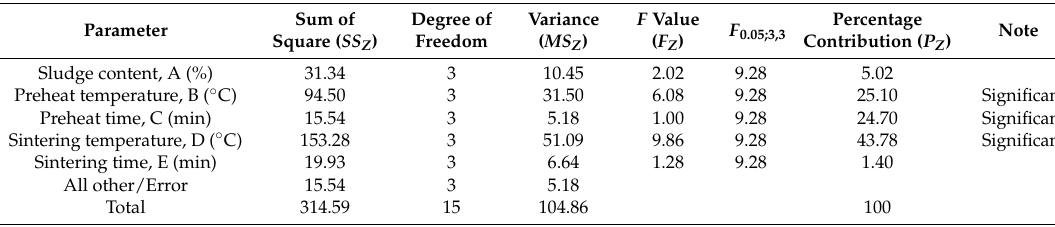
Table 7. Analysis of variance and F test for particle density.